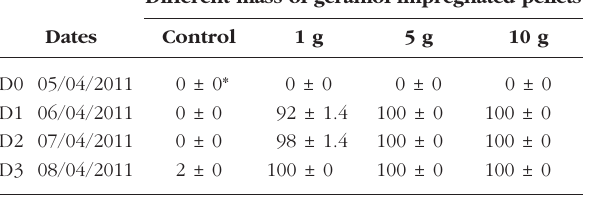
Table III. – Experiment B: larval reduction rates (%) of Ae. albopictus in presence of geraniol impregnated pellets.